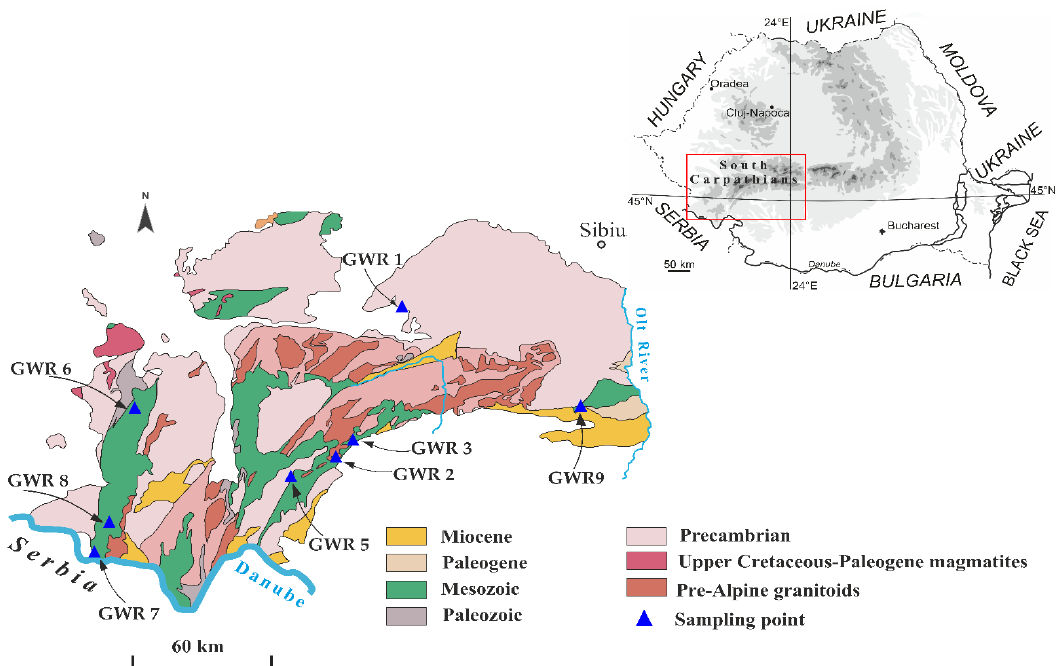
Figure 1. Generalized geological settings of the Southern Carpathians (simplified after S ă ndulescu et al., 1978 [8] ), where the studied springs (GWR1, GWR2, GWR3, GWR5, GWR6, GWR7, GWR8, GWR9) are located.